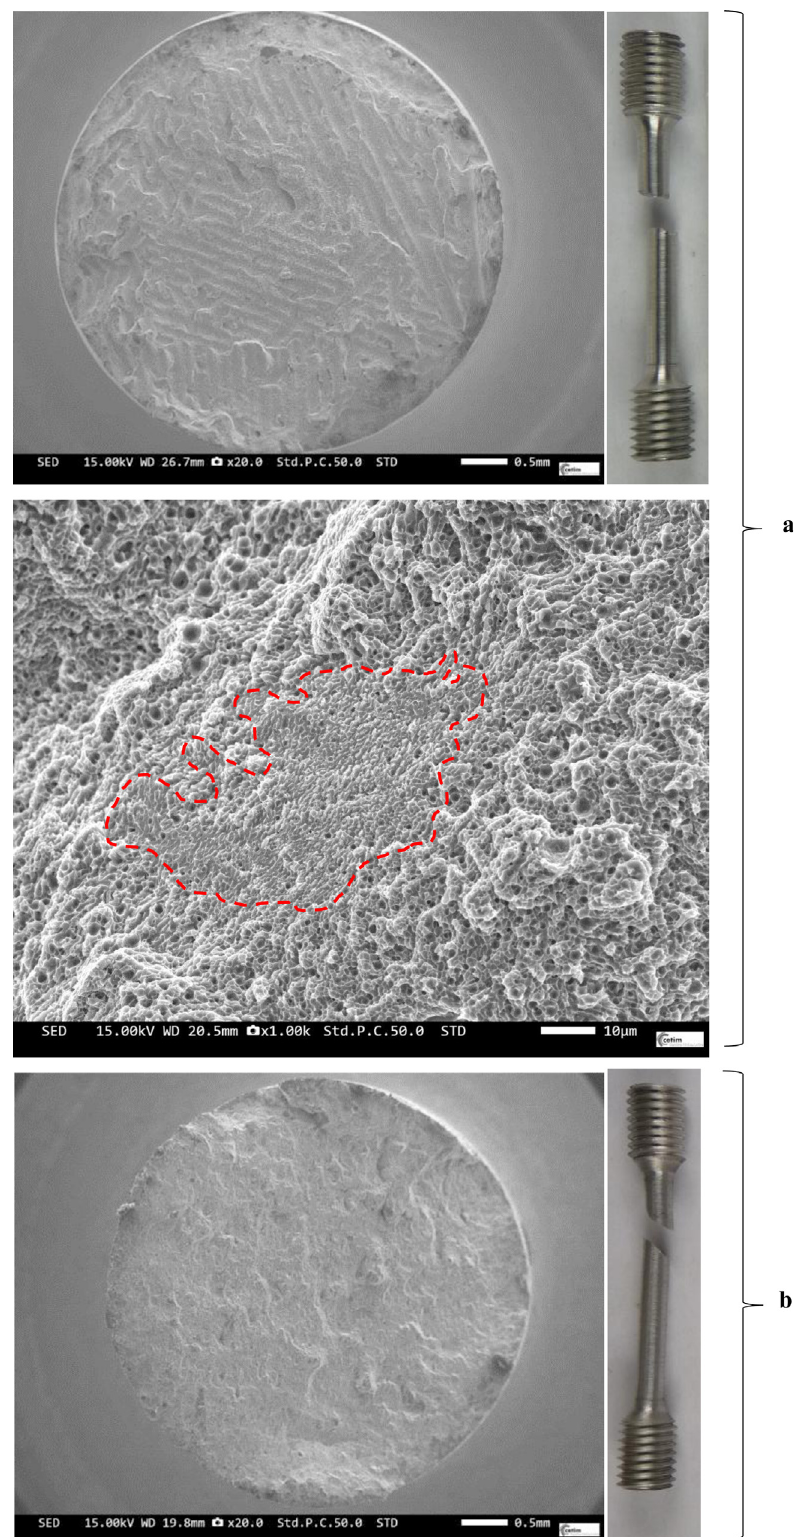
Fig. 9. Fractography (cid:1) Tensile test pieces, as built. (a) Z direction (cid:1) (b) XY